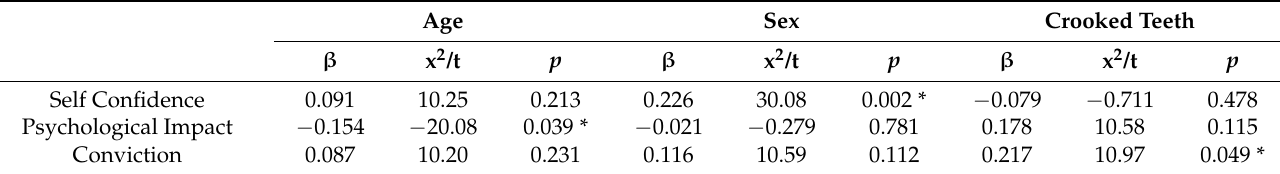
Table 4. Linear regression analysis for numerical data, * p <